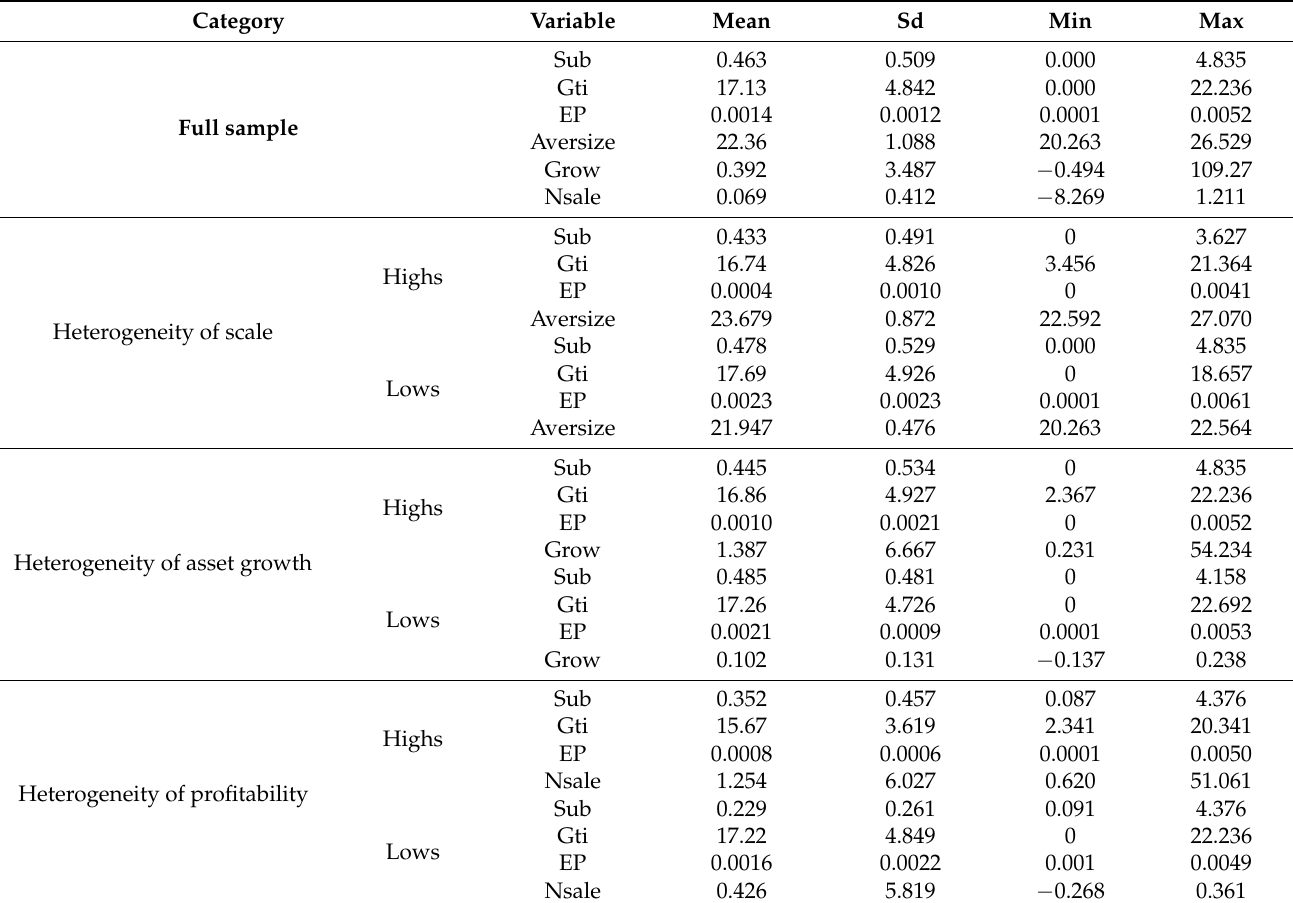
Table 2. Descriptive statistics of